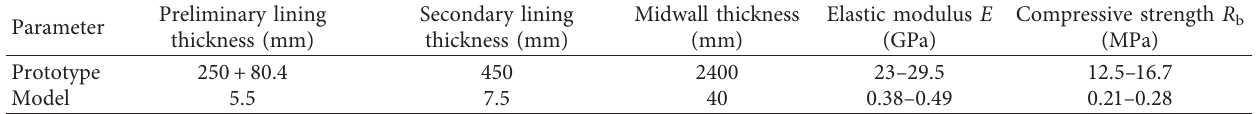
Table 3: Thicknesses and mechanical parameters of linings and midwall prototypes and